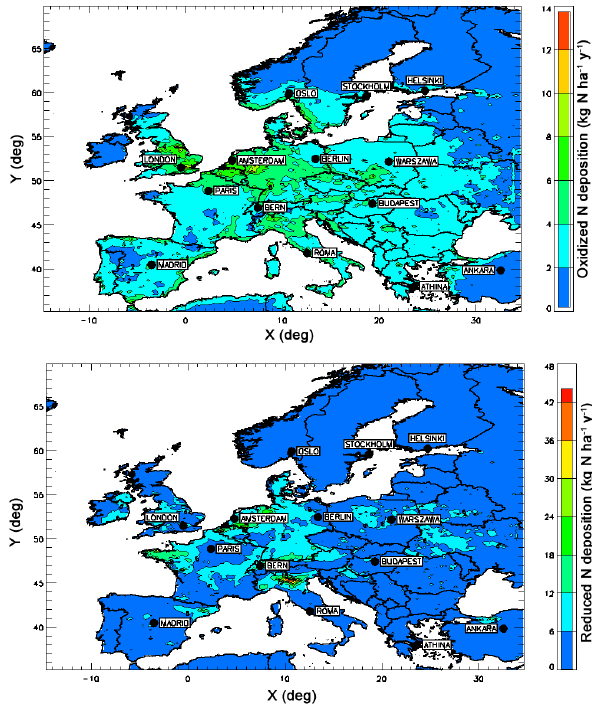
Figure 14. Deposition (kgNha − 1 yr − 1 ) of oxidized (upper panel) and reduced (lower panel) nitrogen compounds over the European domain